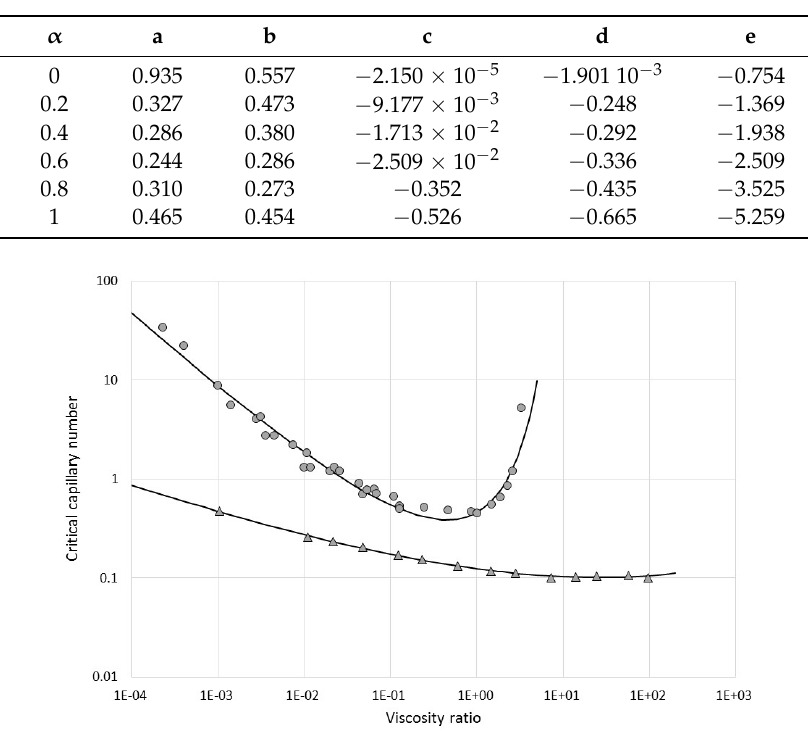
Table A1. Coefficients of Equation (A2), taken from Hill [4].